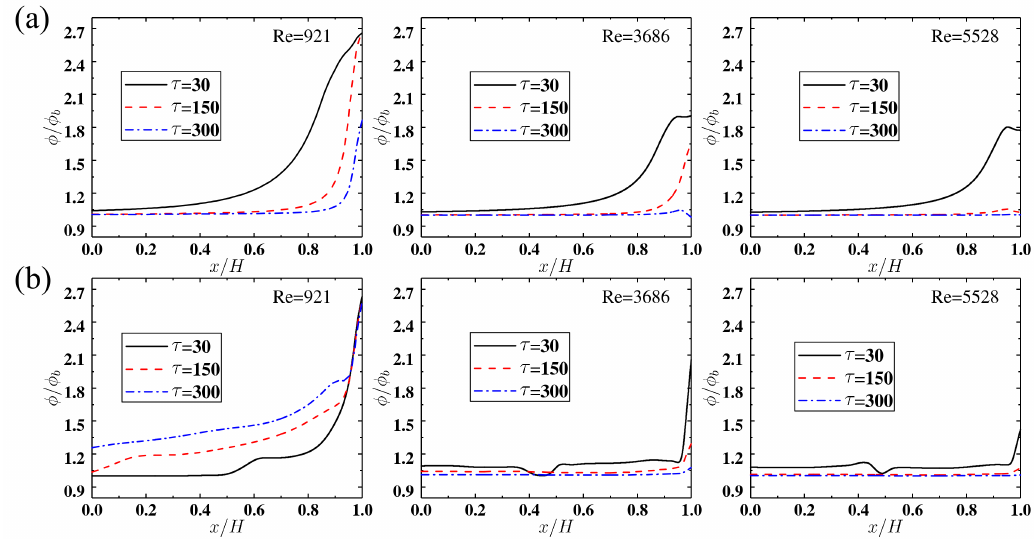
Figure 10. Time evolution of the nanoparticle concentration profiles for different Reynolds numbers. The profiles are plotted along the X-direction at radial positions ( a ) R = 0 and ( b ) R =